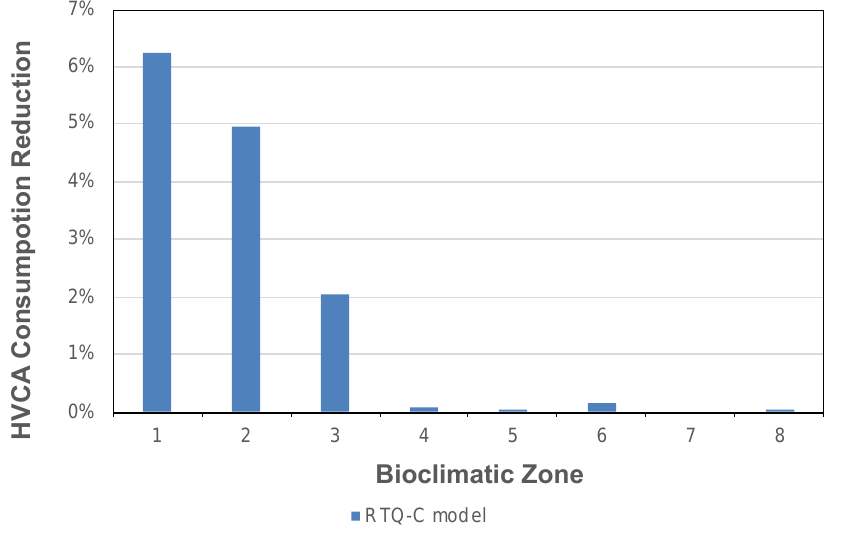
Figure 8. HVAC Reduction for T as isolated optimization control.